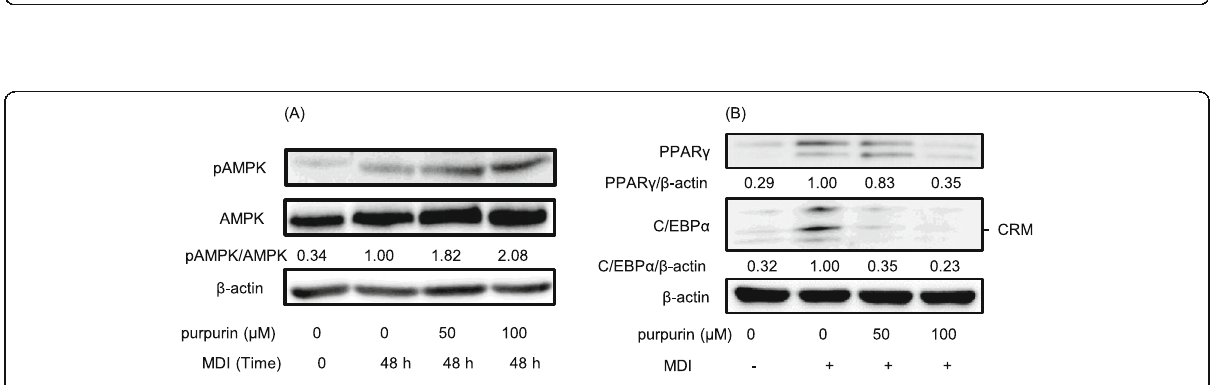
Fig. 5 Western Blot analysis of intracellular proteins from purpurin-treated cells in: a early-stage differentiation (2 d after MDI inducement), and b late-stage differentiation (8 d after MDI inducement). Cells were treated for the first 48 h with MDI and purpurin, after which these substances were removed from the culture. Figures represent results from at least three individual experiments. AMPK activity was expressed as the ratio phosphorylated to non-phosphorylated AMPK. Protein expression was calculated relative to β -actin, a constitutively expressed cellular protein